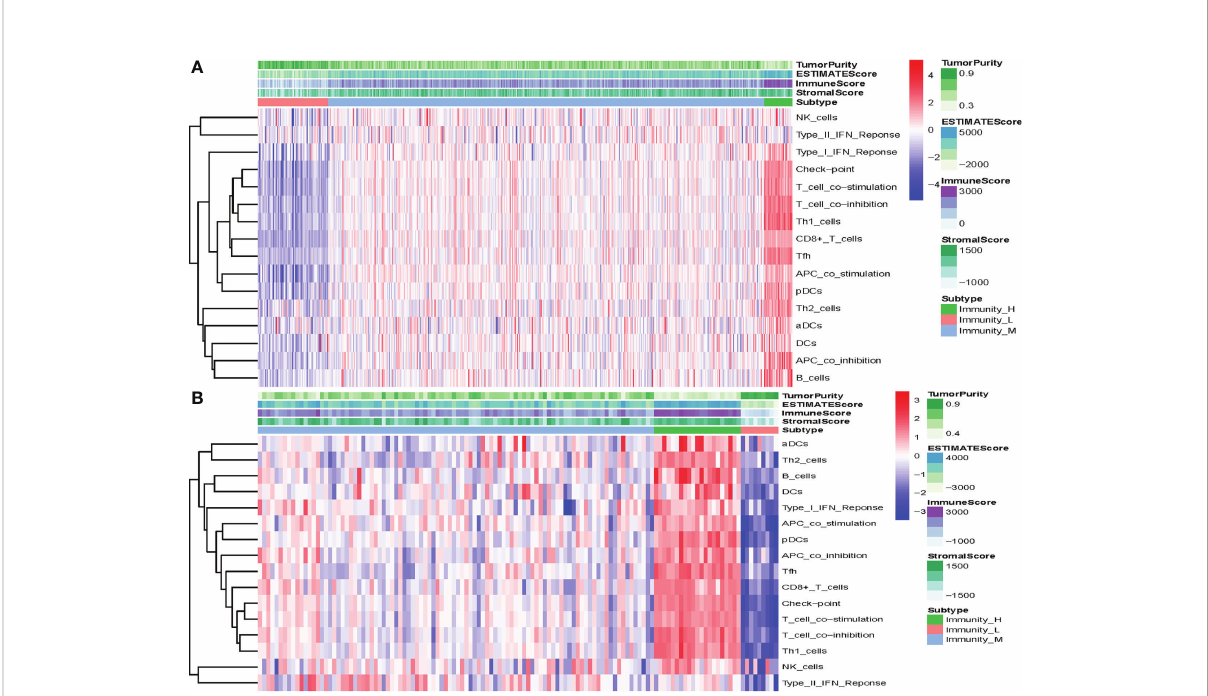
FIGURE 1 Construction of the immunotype of ccRCC. (A) Heat map showed that the patients were clustered into three groups: high-immunity, moderate-immunity, and low-immunity in the discovery set. (B) The patients were clustered into high-immunity, moderate-immunity, and low- immunity groups in the validation set using the same